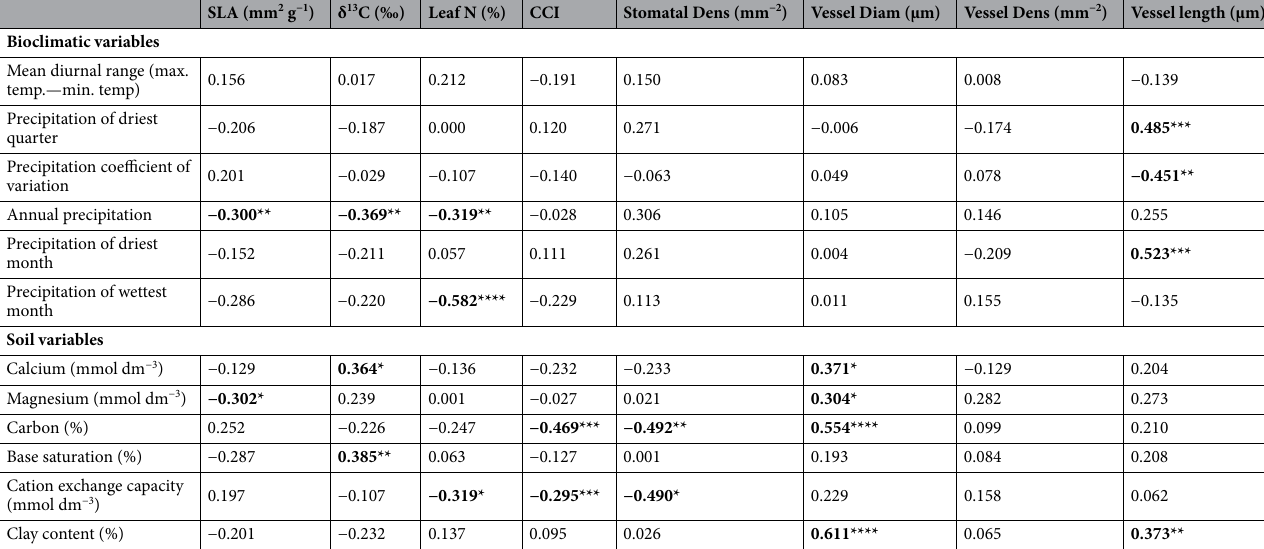
Table 1. Leaf and wood functional traits are influenced by climatic and soil conditions. Linear correlation among phylogenetically independent contrasts of leaf and wood functional traits and their respective bioclimatic and soil variables. Functional traits were measured in 24 geographically widespread populations. Bioclimatic values were extracted from the Worldclim dataset and soil features were obtained from chemical analysis. Significant correlations bolded (* P < 0.05; ** P < 0.01; *** P < 0.001; **** P < 0.0001). SLA specific leaf area, δ 13 C carbon stable isotopes, N nitrogen, CCI chlorophyll content index, Dens. density, Diam.